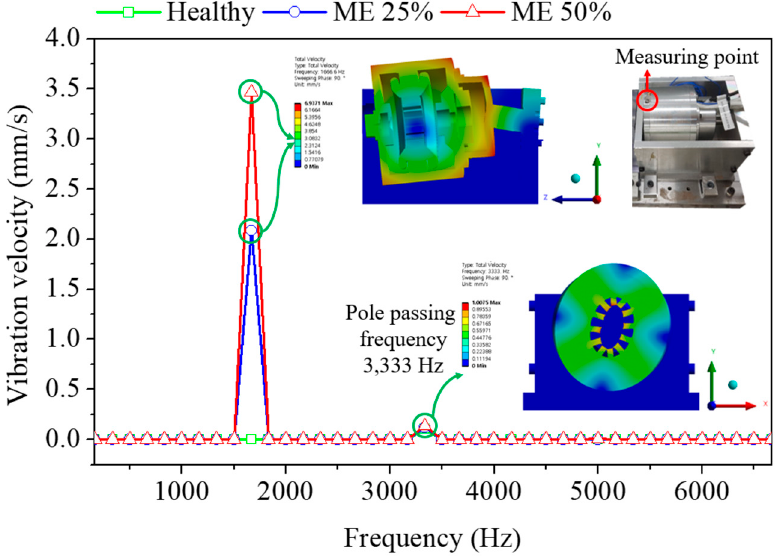
Figure 9. Vibration velocity of Y-axis direction considering mixed eccentricity and measuring